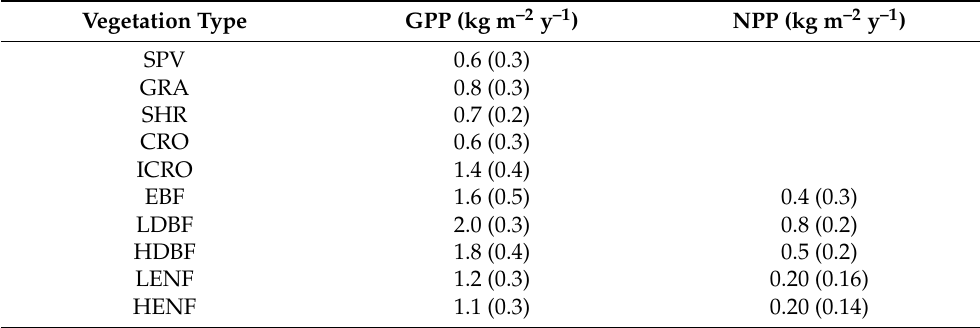
Table 2. Average annual GPP and NPP. Only pixels with coherent classification between Figures 1c and 1d were used in the calculations of the means and the standard deviations (between brackets). SPV (sparse vegetation), GRA (grasslands), SHR (shrublands), CRO (rainfed croplands), ICRO (irrigated crops), EBF (evergreen broadleaved forest), LDBF (low-altitude deciduous broadleaved forest), HDBF (high-altitude deciduous broadleaved forest), LENF (low-altitude evergreen needle-leaved forest), and HENF (high-altitude evergreen needle-leaved